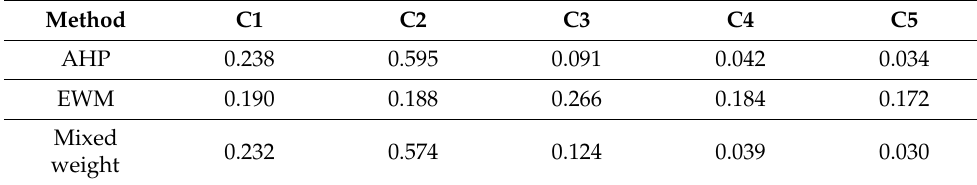
Table 10. Mixed weight of evaluation index.